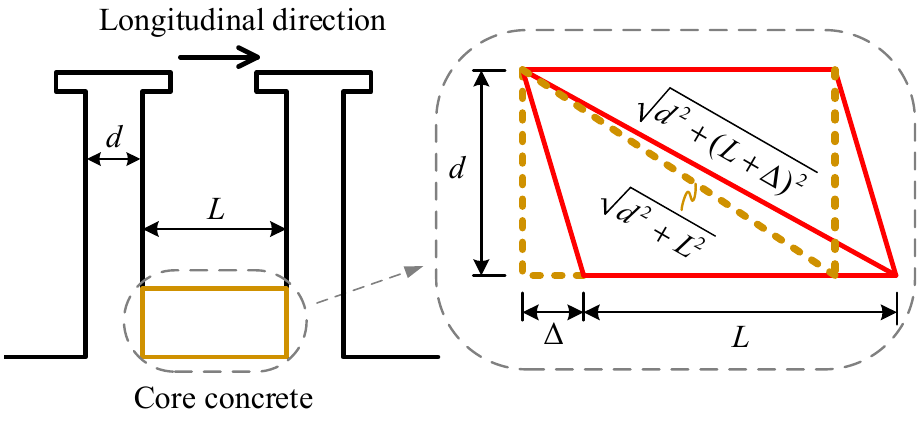
Figure 3. The deformation of the surrounding concrete at the stud’s root.